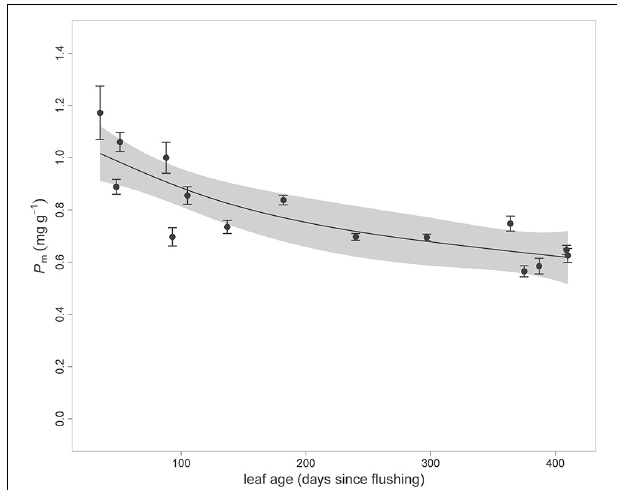
FIGURE 1 | Means and standard errors of mass-based leaf phosphorus concentrations (P m ) since leaf flushing for each campaign across years, showing a decline in P concentrations over the lifetime of leaves (expressed as days since flushing where leaves are ‘new’ when < 90 days). The line shows the trend fit using a generalized additive model (GAM), and the gray area shows the 95% confidence interval around the mean decline in P m . Mass-based N as a function of leaf age can be found in Wujeska-Klause et al.